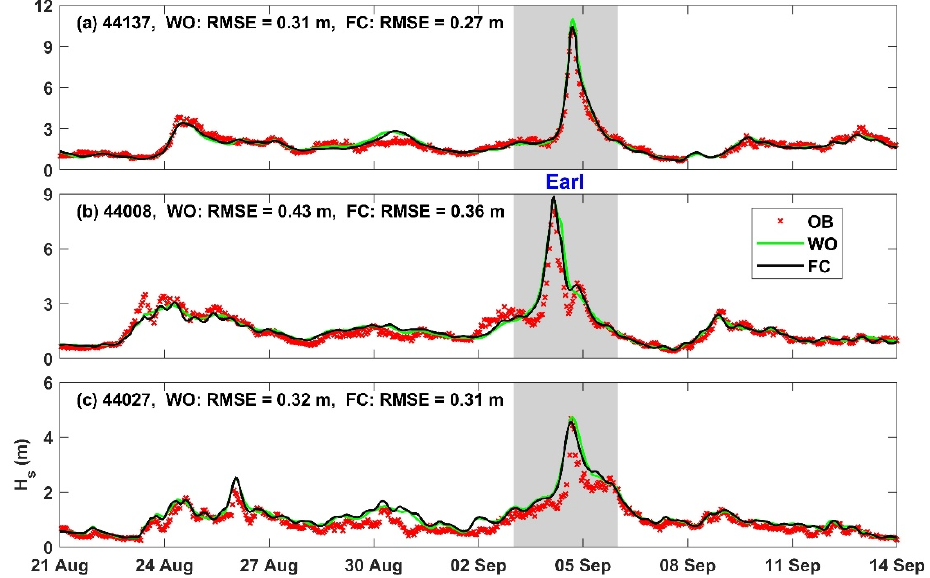
Figure 5. Comparison of the observed SWHs (OB) and simulated values (WO and FC) at ( a – c ) three wave buoys during the study period. Values of the RMSE for runs WO and FC are also shown.